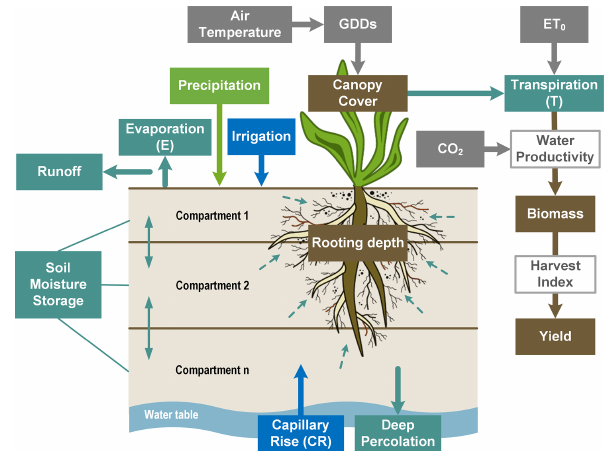
Figure 2. AquaCrop simulation scheme. Green, blue, and cyan boxes represent variables related to the soil water balance, brown boxes to crop growth, and grey boxes to climate. We only abbrevi- ate the terms that are often used in the